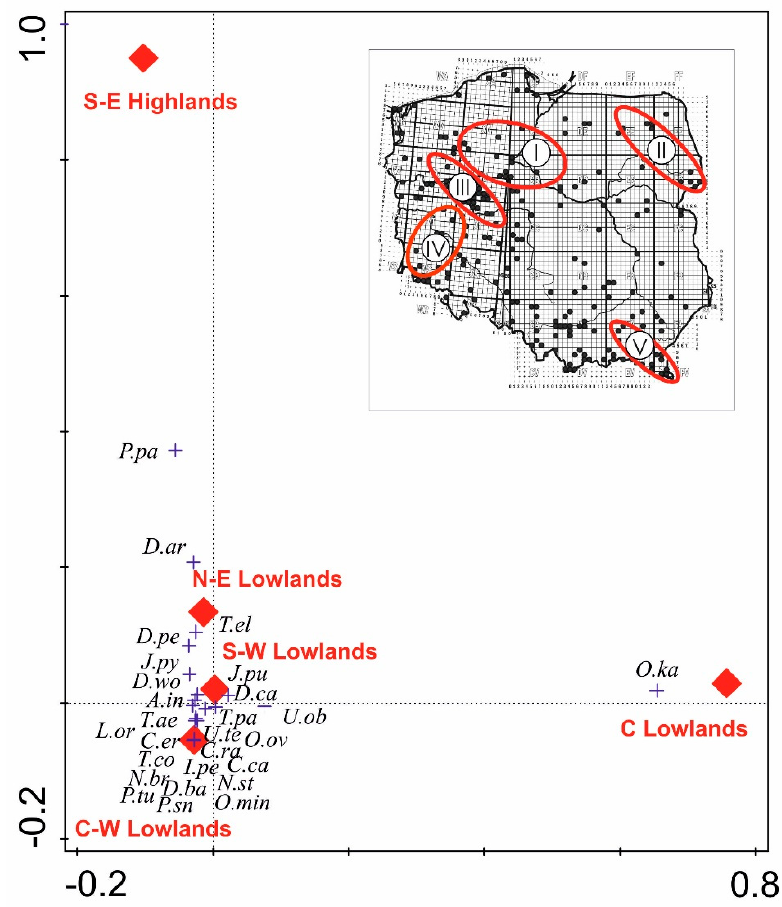
Figure A3. Canonical Correspondence Analysis (CCA) scatterplot showing the relationships between examined Uropodina mite communities from oaks ( Queracus robur and Q. petrea ) from different lowland regions of Poland from 4 samples from south-western lowlands (Lower Silesia) (IV), 8 from central lowlands (Kuyavia) (I), 44 from north-eastern lowlands (Podlachia and Warmia) (II), 5 from south-east of Poland (V) and 177 from western lowlands (Greater Poland) (III) on the first two axes. First and second axis explained 3.72% of variation (pseudo-F = 2.8, p = 0.014). Abbreviations of species are included in Section 2.